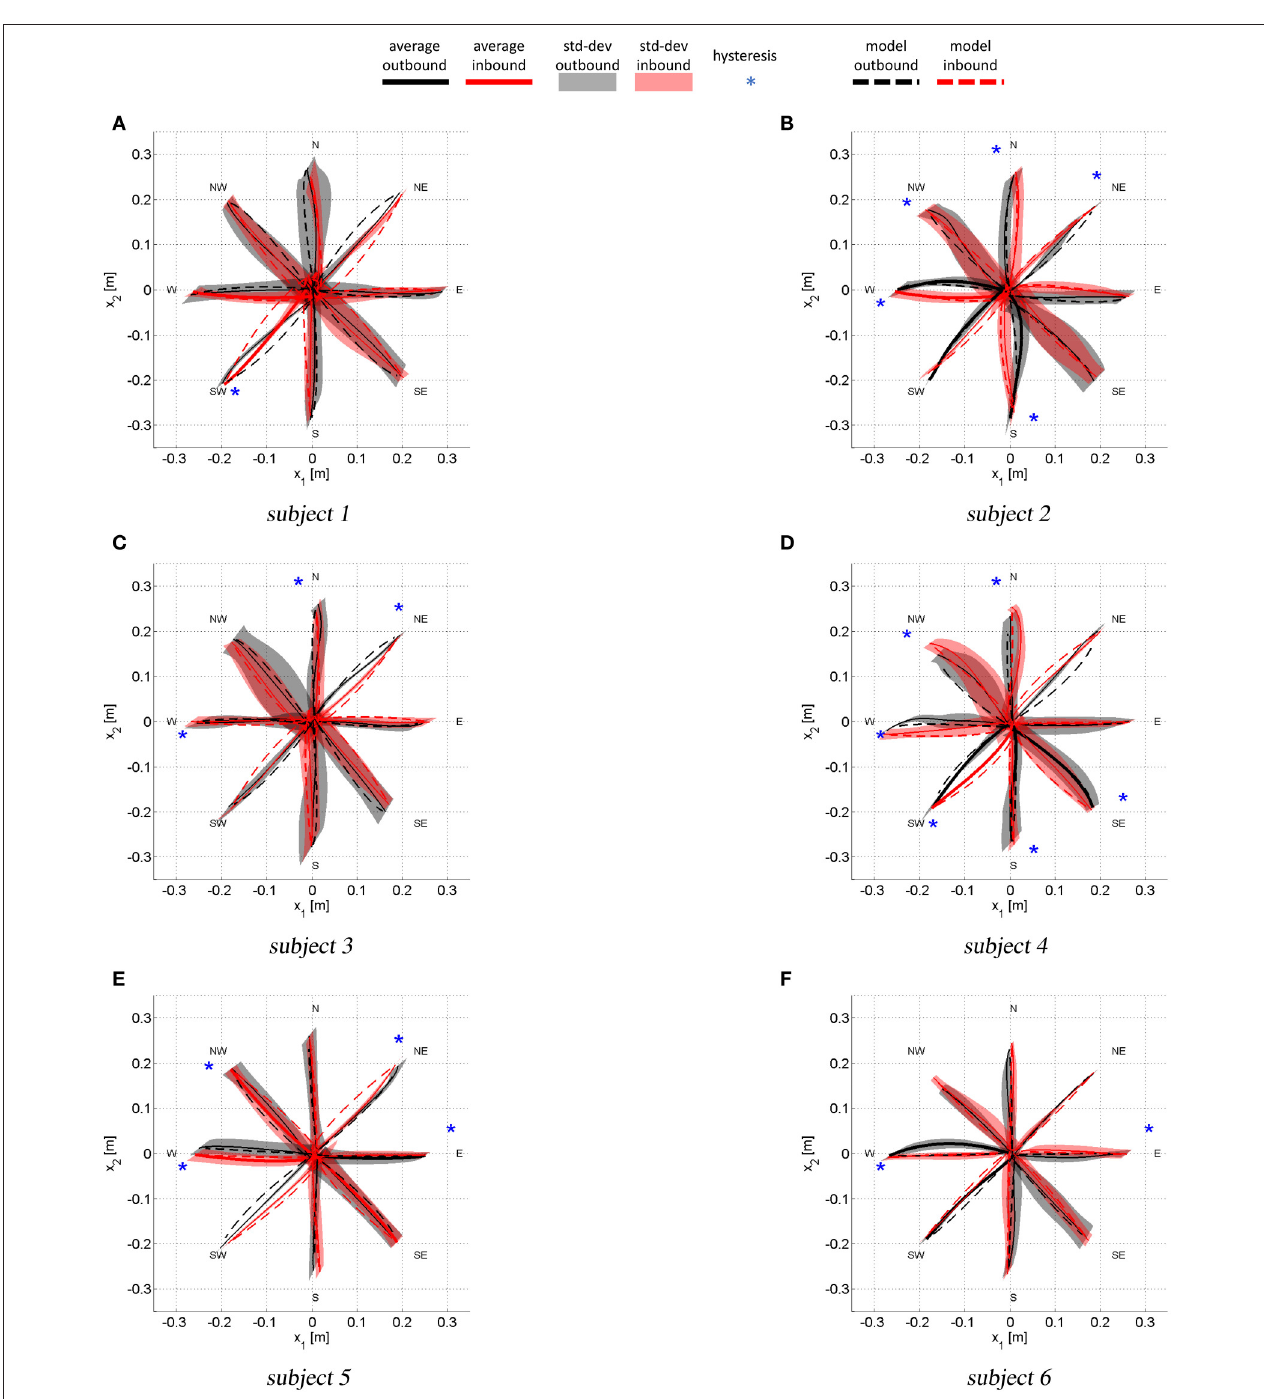
FIGURE 5 | Average task-space trajectories. Shaded areas show the standard deviations for both outbound and inbound movements. Thick lines are relative to paths with A net statistically different from zero (i.e., a preferred curvature direction). The stars mark movement for which A IN net was statistically different from A OUT net , i.e., those movement that present hysteresis.